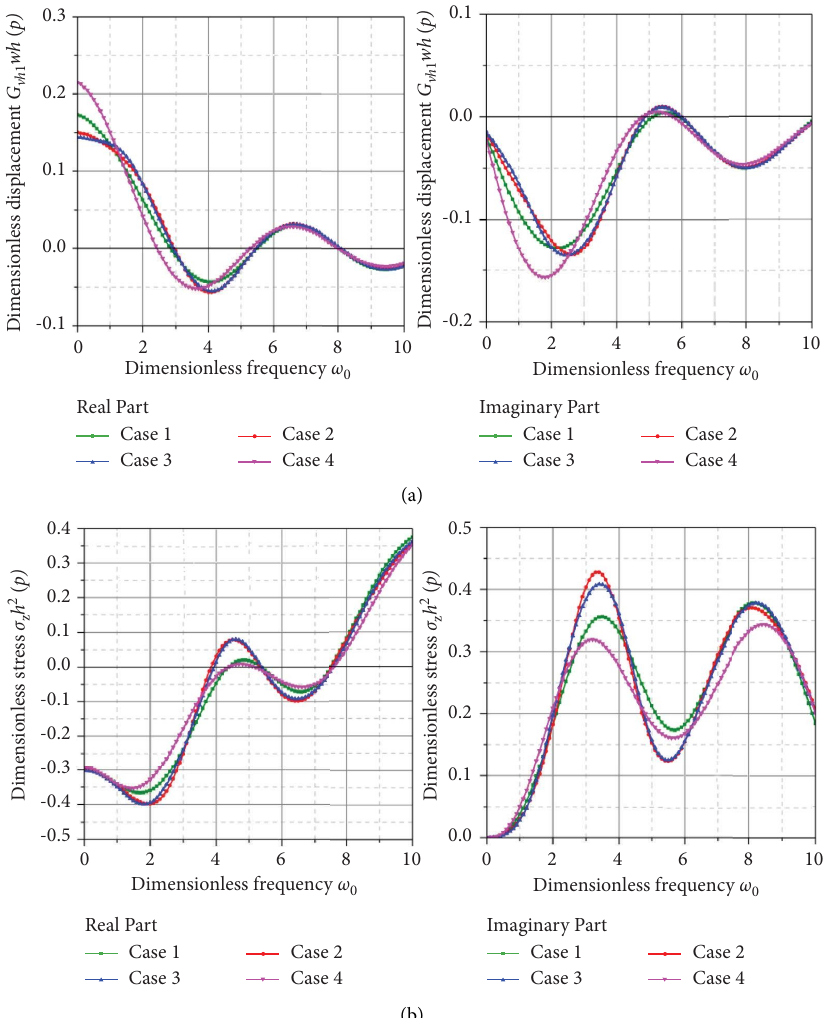
Figure 14: Te real part and imaginary parts of (a) the vertical displacement and (b) the vertical stress at a fxed surface point ( r , θ , z ) � (0, 0, 0) for the diferent cases versus the dimensionless